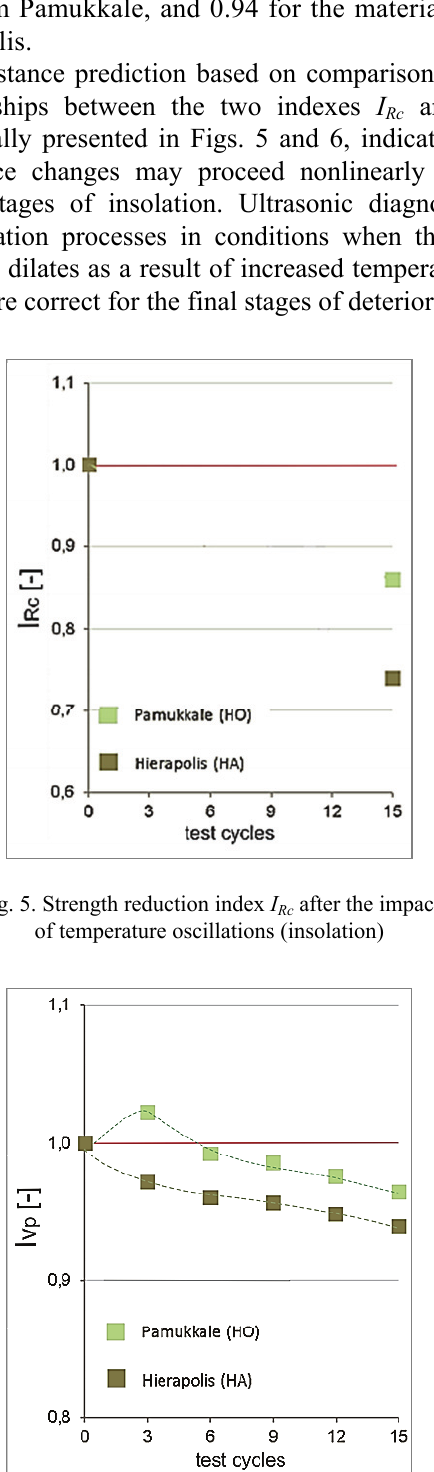
Fig. 6. Ultrasonic waves index I Vp after the impact of temperature oscillations